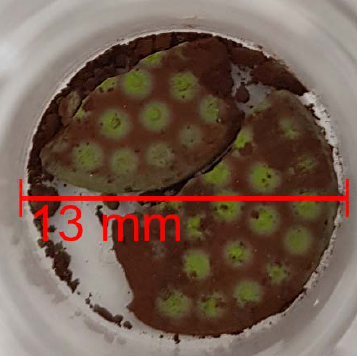
Figure 2. Bottom side of the Ba 2 In 1.8 Cr 0.2 O 5.3 (H 2 O) x sample after being heated in nitrogen flow ( p = 0.15 MPa, p (O 2 ) < 5 ppm, p (H 2 O) < 5 ppm) at 1123 K.